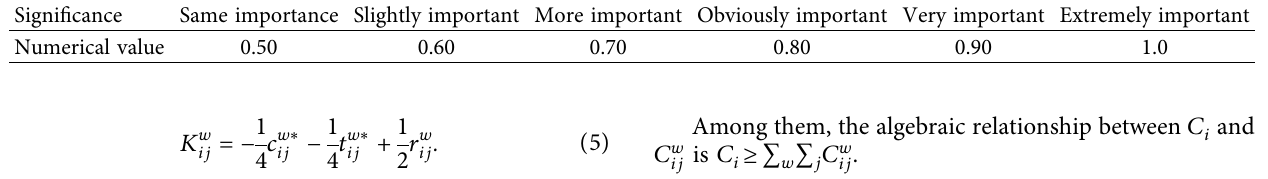
Table 1: Numerical description of connection